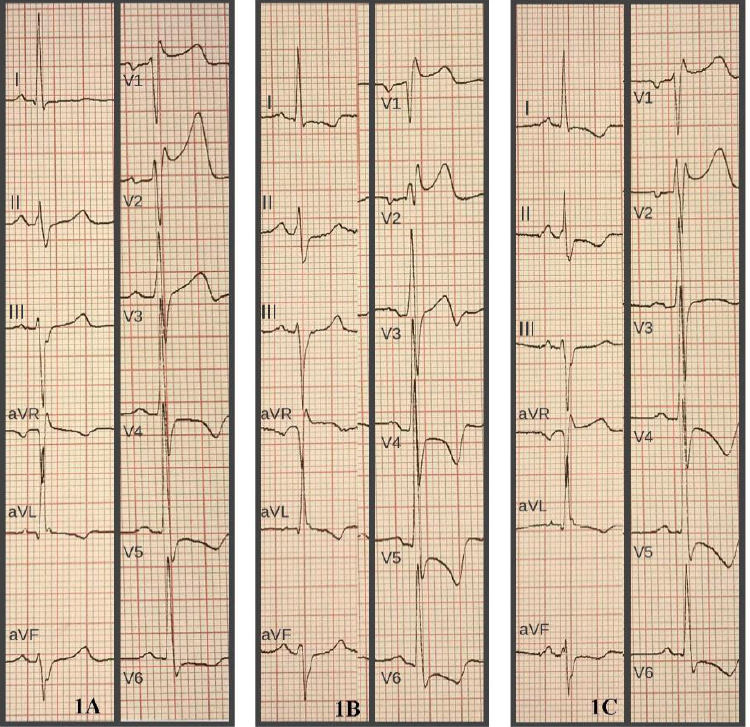
Figure 1. Dynamic electrocardiographic changes. ( A ): Electrocardiogram on admission. ( B ): Recurrence of chest pain; note the ST segment depression in V4-V5-V6. 1 ( C ): After therapy with beta-blockers and nitrates; modest regression of ischemic alterations.